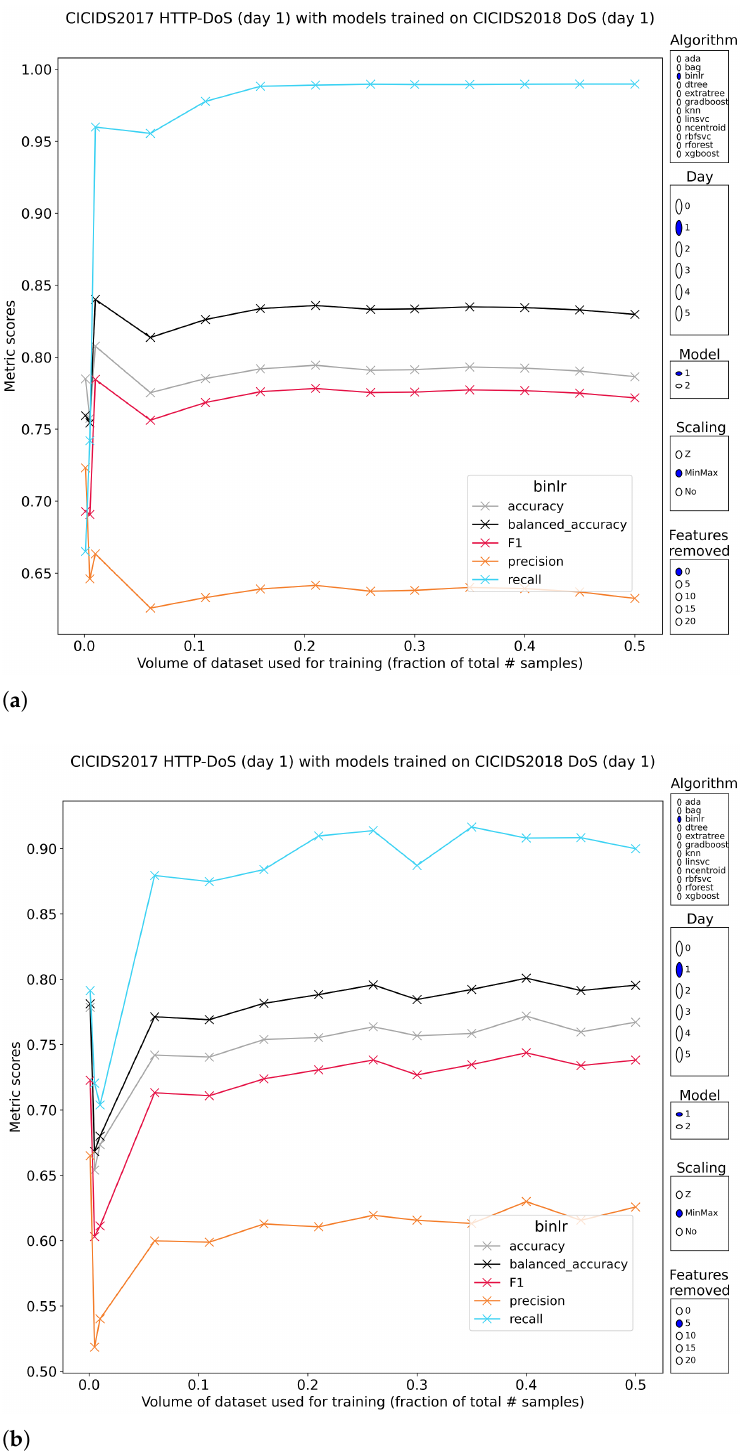
Figure 7. Generalized performance of logistic regression models on the L7-DoS attack class, which show reasonable